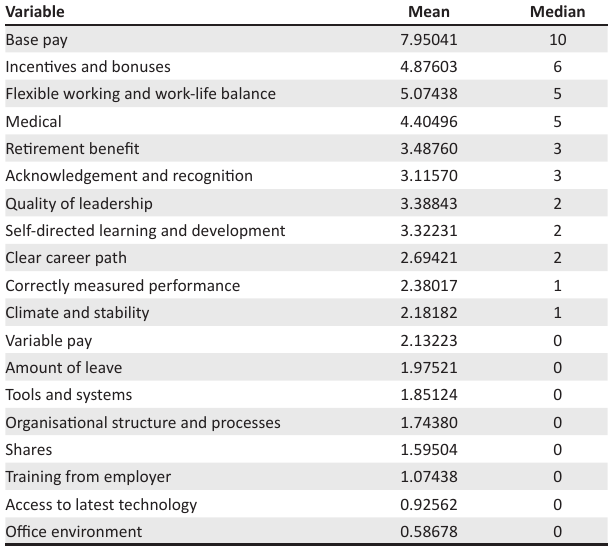
TABLE 7: Summary of rank scores for retention.